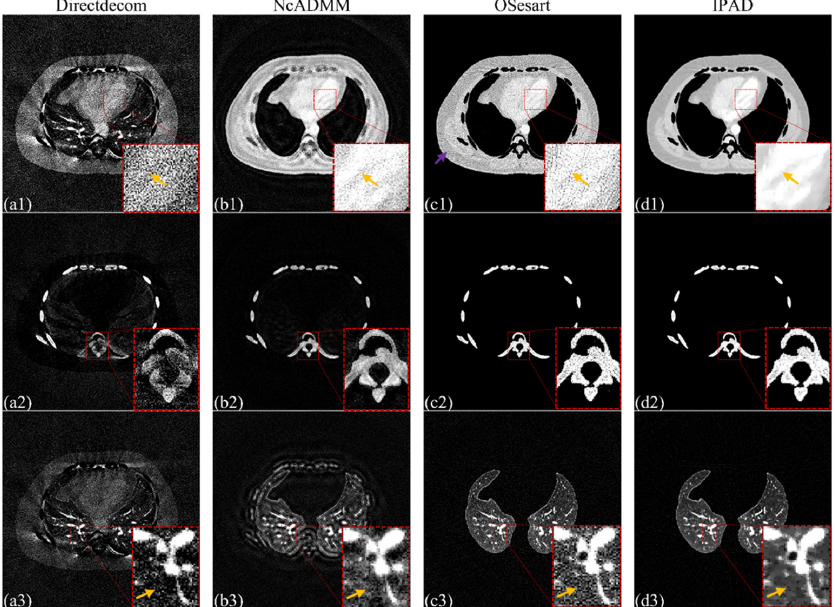
Figure 10. Results of the thorax dataset obtained by different methods with added noise (I 0 = 1 × 10 6 ). ( a1 )–( a3 ), ( b1 )–( b3 ), ( c1 )–( c3 ), and ( d1 )–( d3 ) represent the tissue, bone, and iodine obtained by Di-